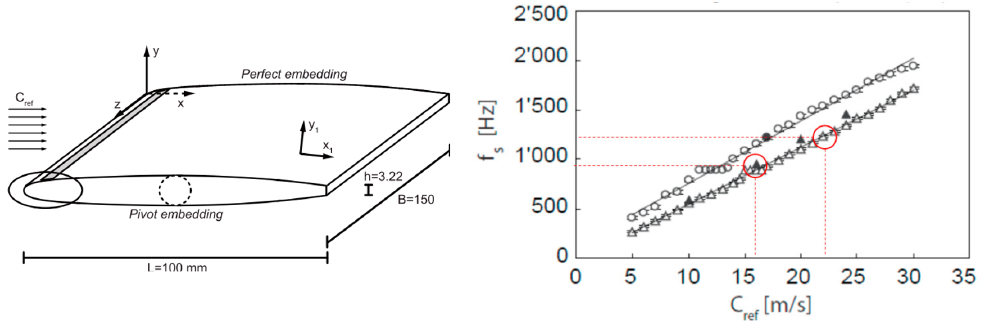
Figure 15. ( Left ): Boundary conditions for the NACA0009 hydrofoil. ( Right ): Results compared to experiments [58].